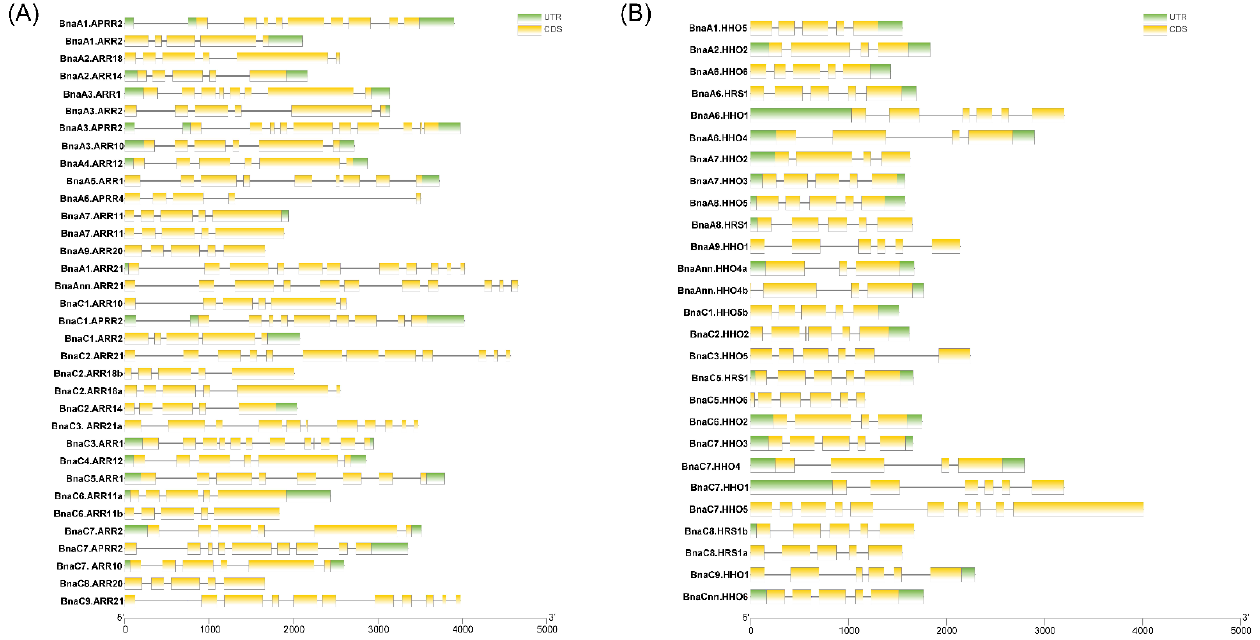
Figure 3. Exon-intron organizations of BnaNIGT1/HRS1/HHOs ( A ) and BnaARR-Bs ( B ). The green boxes represent untranslated regions, the yellow boxes represent exons, and the black lines represent the introns. The lengths of the exons and introns can be determined by the scale at the bottom.